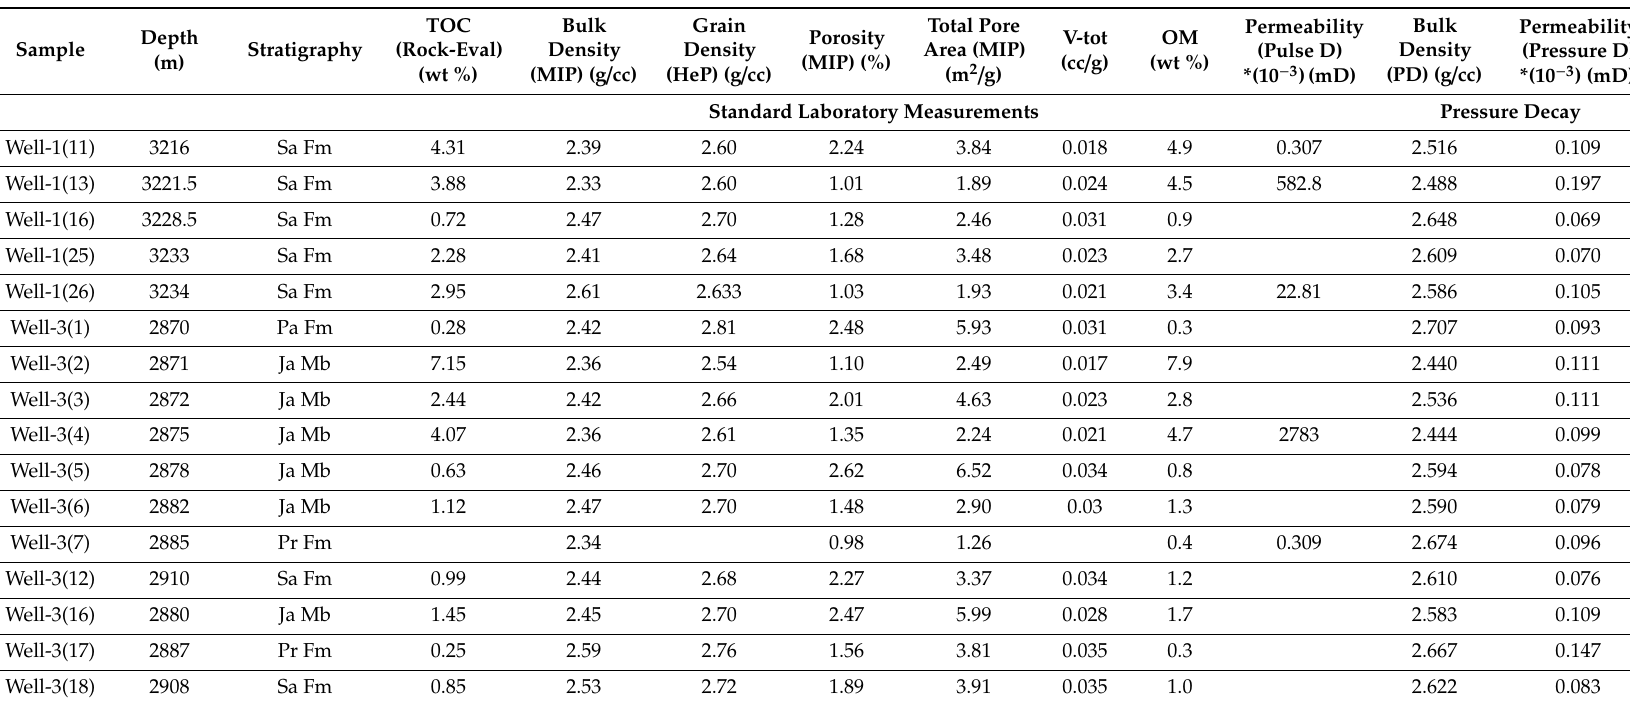
Table 2. Petrophysical parameters of the samples selected for the pressure decay permeability and other laboratory measurements.